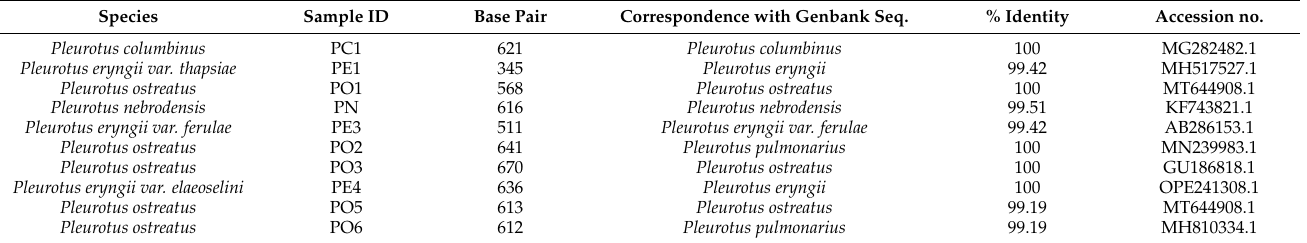
Table 2. GenBank sequences and identity percentages with different samples of Pleurotus species